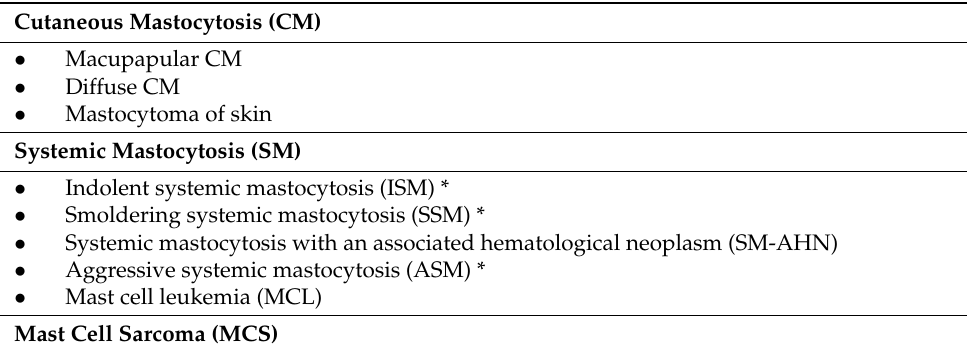
Table 1. WHO 2016 classification of